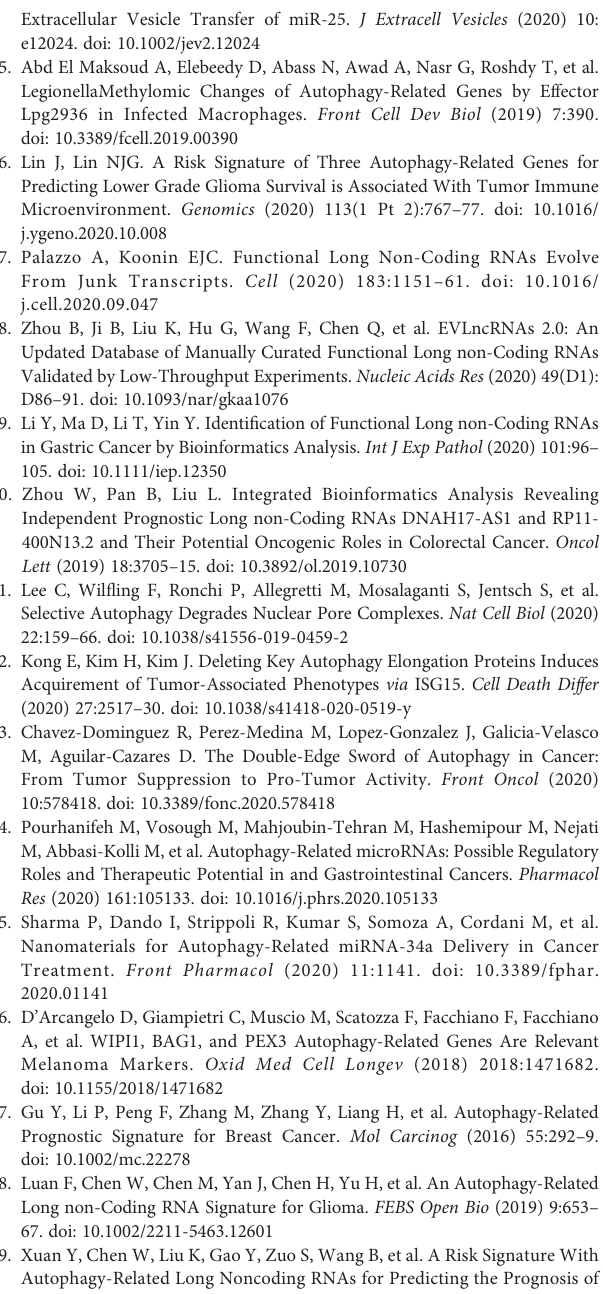
Supplementary Table 1 | The clinical information of ccRCC samples in TCGA